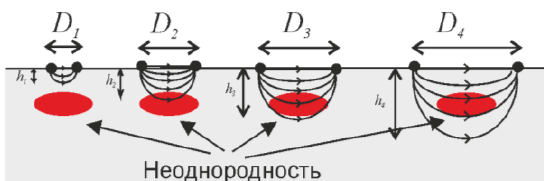
Fig. 2. Scheme of a deep sensing of inhomogeneous media by the method of resonance near-field micro- wave